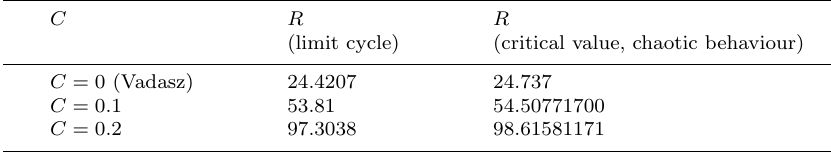
Table 1. Comparison between Vadasz case ( C = 0) and the couple-stress case for C = 0 . 1 and C = 0 . 2 with Pr = 10, λ = 8 / 3 for R a solitary limit cycle signifying the loss of stability of the steady convection fixed points and the critical value of R at which the chaotic behaviour solution occurs.